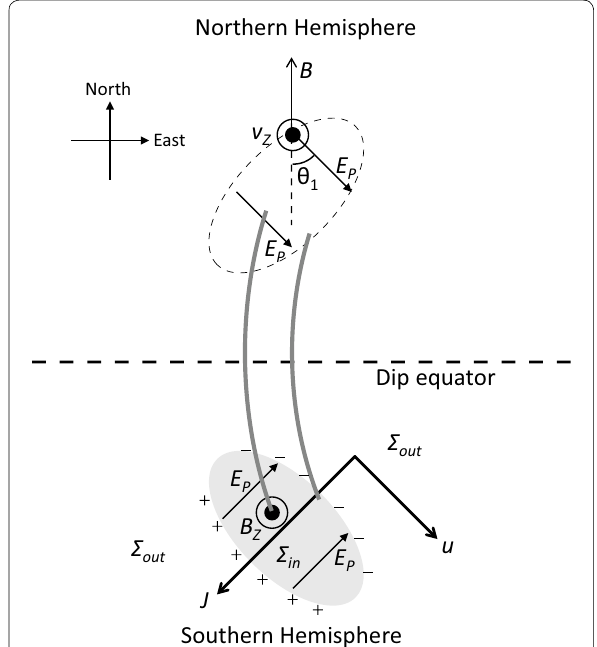
Fig. 7 A schematic picture of the possible ionospheric variations during the MBW event on February 7, 2011. u is the thermospheric neutral winds at Kototabang, J is an ionospheric current, E P is a polari- zation electric field, B Z and B are the vertical and total components of the geomagnetic field, respectively, v Z is an upward E × B drift, and (cid:31) in and (cid:31) out are height-integrated Pedersen conductivities inside and outside MBW, respectively. We suggest that the polarization electric field inside the observed midnight brightness wave in the southern hemisphere is projected to the northern hemisphere, causing the observed ionospheric height increase in the northern